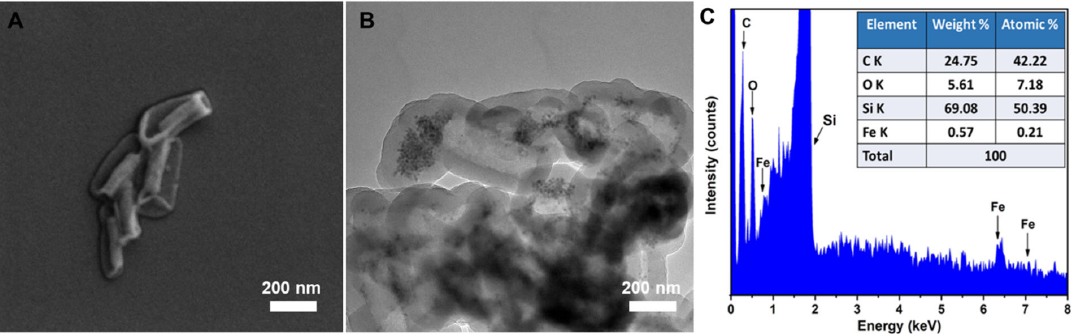
Figure 4. SEM ( A ), TEM ( B ) images and EDX analysis ( C ) of Fe 3 O 4 filled PDA HR. 2.2. Loading and Controlled Release of Fosfomycin from Fe 3 O 4 @PDA HR